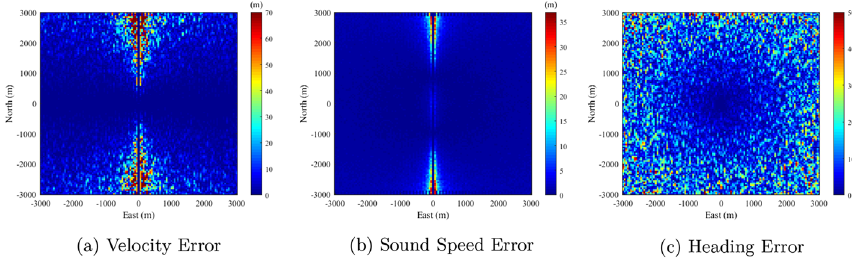
Fig. 5 Influence of each error for ASBL positioning